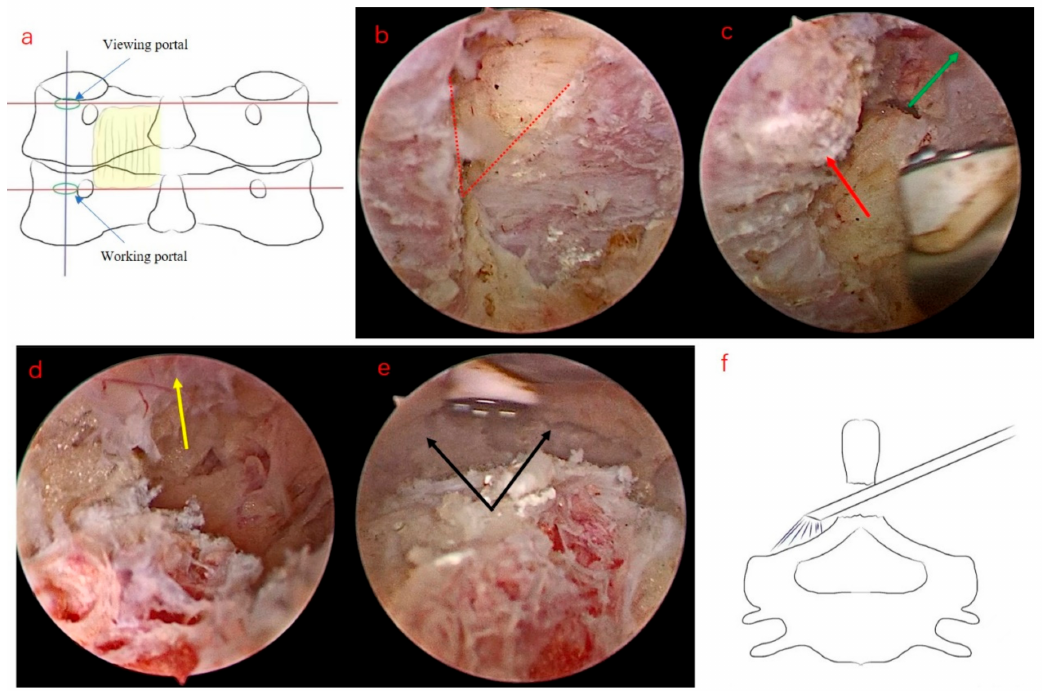
Figure 2. ( a ) Schematic representation of the location of the portals. ( b – d ) Intraoperative photographs: “V” point (dotted lines), C5 SP (red arrow), C6 SP (green arrow) and the spared tip of C5 SP (yellow arrow). ( e ) The contralateral laminae were easily exposed (black arrows). ( f ) After the tip of the SP was spared, the endoscope could easily reach the contralateral